Question: What type of chart is this?
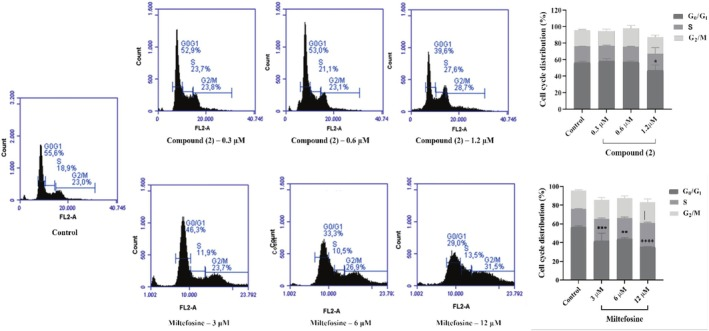
Answer: histogram